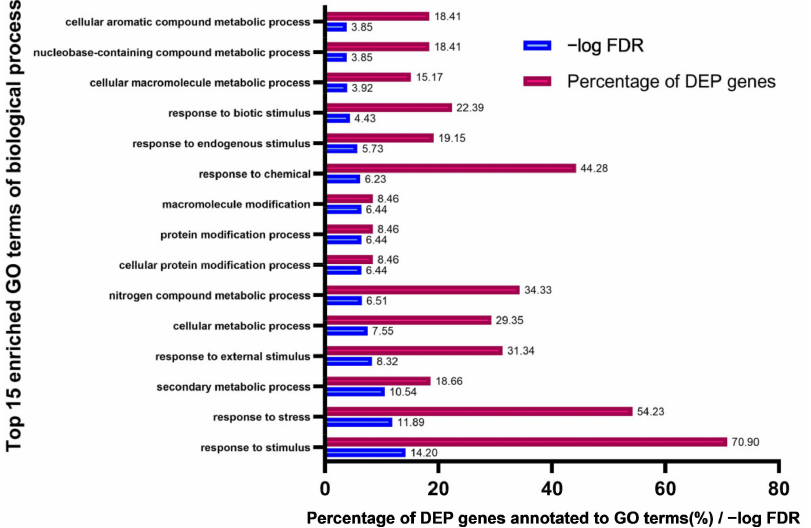
Figure 7. Top15 enriched gene ontology (GO) terms of biological processes from the 428 differentially expressed proteins (DEPs) in the CEP-XSP1ox soybean hairy root proteome. The enriched GO terms were ranked by their -log FDR value, which is indicated with the blue bar. The percentage of genes annotated to the GO terms relative to the total number of genes in the input list is indicated with the red bar